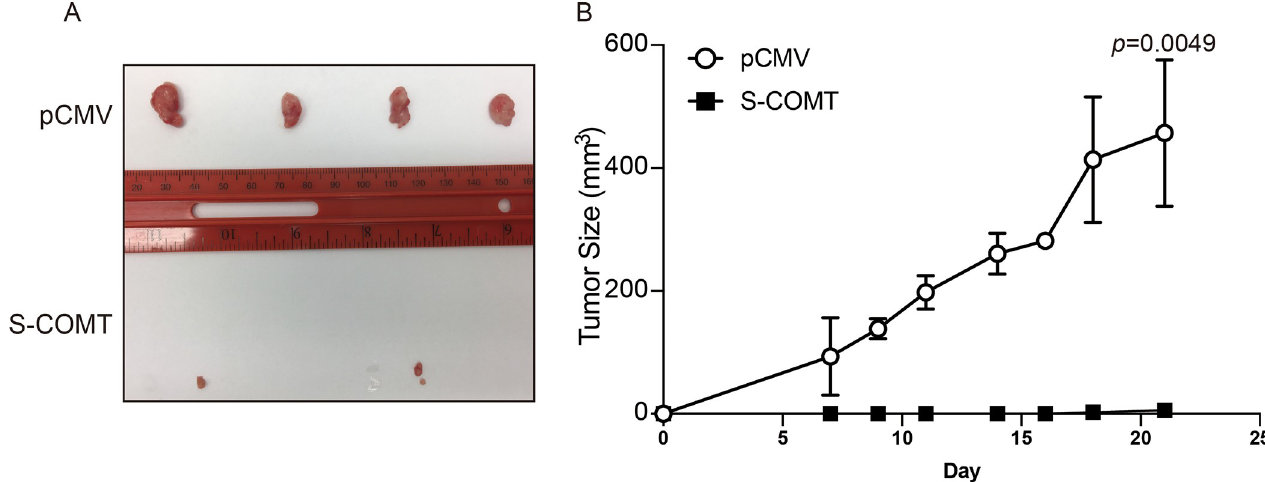
Fig 3. Expression of S-COMT suppresses xenograft growth of cells in vivo . Four athymic nude mice were injected subcutaneously with stable S-COMT (left flank) or pCMV-transfected (right flank) DuPro cells and growth determined over time. (A) Tumors extracted from mice after 21 days. (B) Tumor size (mm 3 ) over time. Data are presented as mean ± SD. The p -value is based on paired t-test.